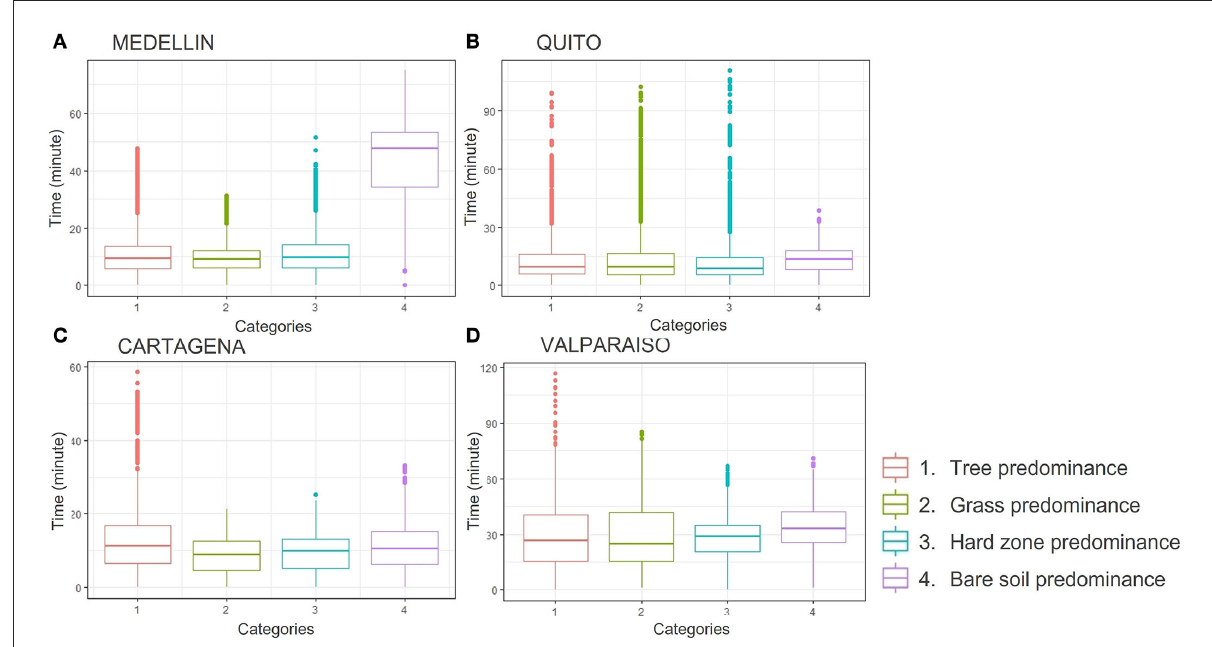
FIGURE9 Accessibility by time ranges to public spaces and UGA: Medellín (A) , Quito (B) , Cartagena (C) , and Valparaíso (D). Sources: Prepared by the